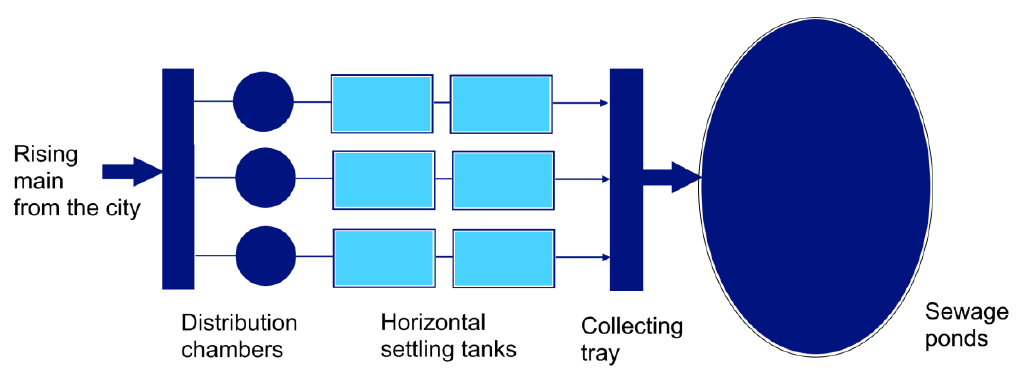
Figure 1. Scheme of wastewater treatment facilities for the city of Kostanay.